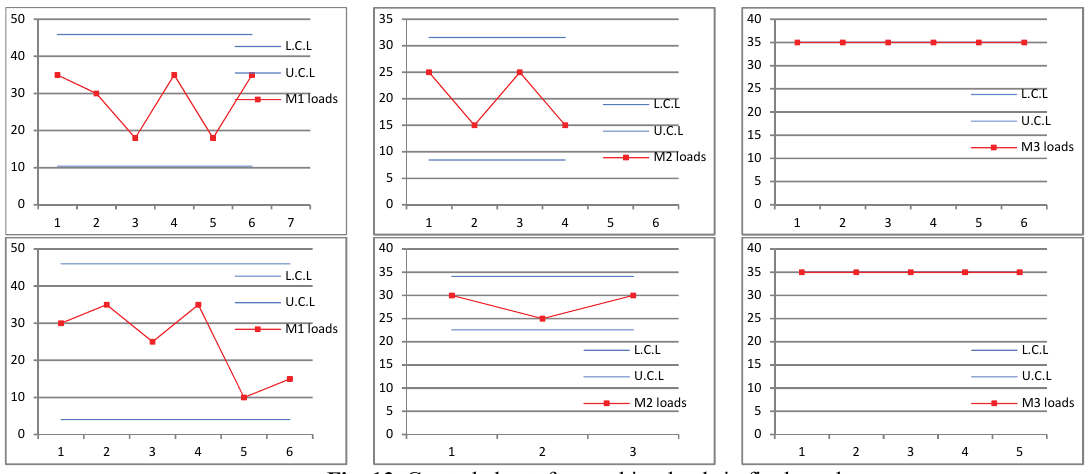
Fig. 13. Control charts for machine-loads in final